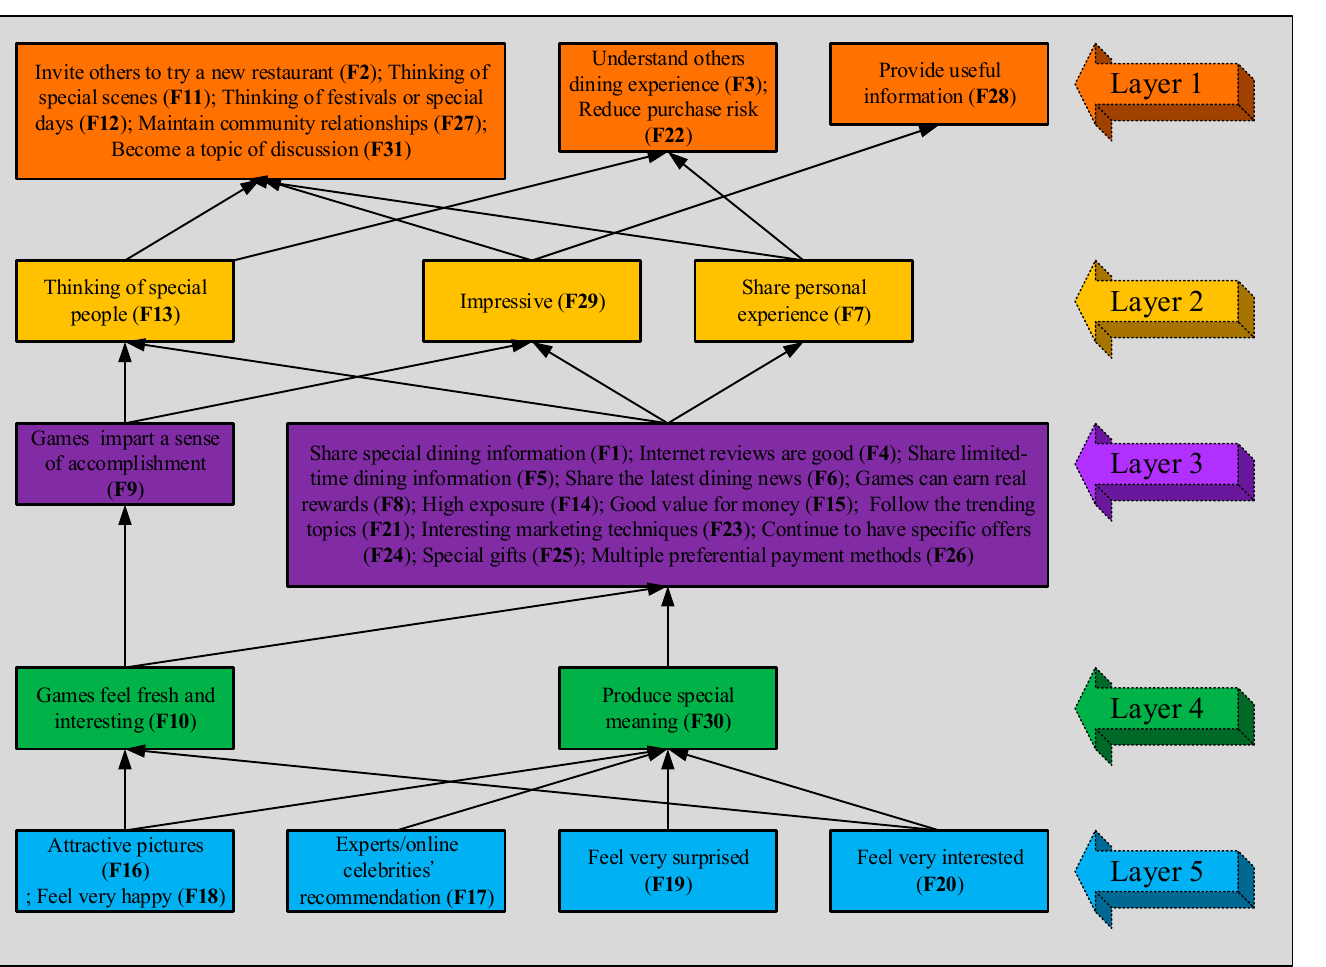
Figure 4. Interpretive structural modeling framework of enablers.